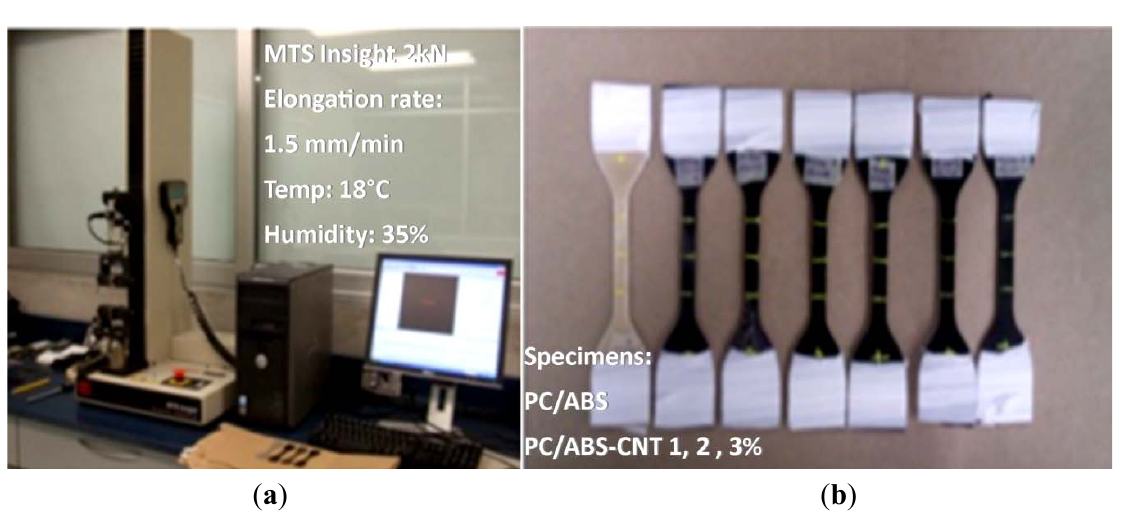
Figure 11. Experimental setup for PC/ABS composites. ( a ) Universal testing machine